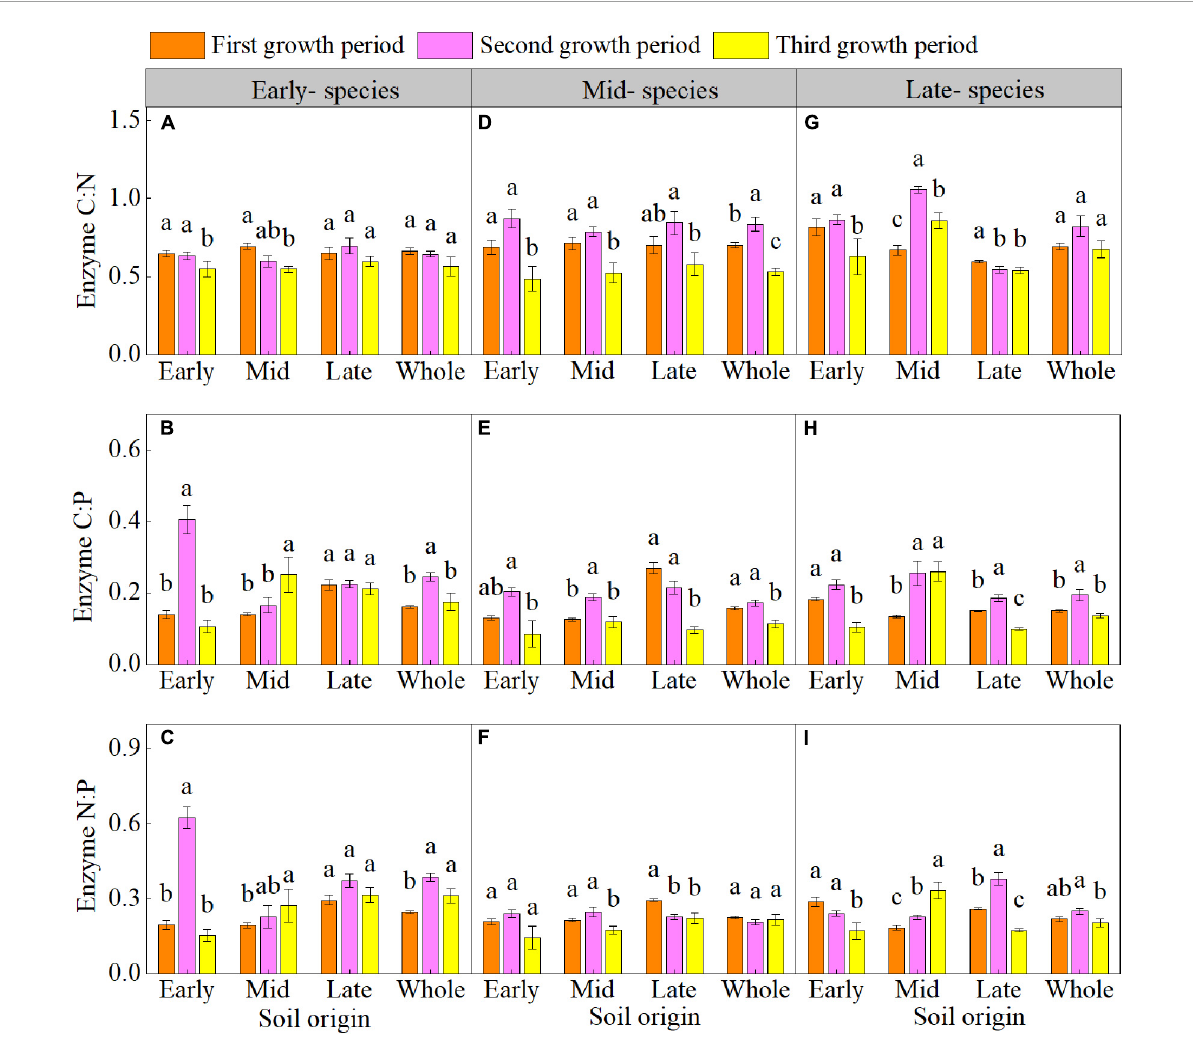
FIGURE3 Mean ( ± SE) ( n = 5) enzyme carbon-nitrogen-phosphorus stoichiometry (enzyme C:N, enzyme C:P, and enzyme N:P) of early- (A–C) , mid- (D–F) , and late- species (G–I) over the three growth periods. “Whole” is the average enzyme C:N, enzyme C:P, and enzyme N:P of the same species in the three soils. Different lower letters indicate significant differences in mean enzyme C:N, enzyme C:P, and enzyme N:P among the three growth periods based on Duncan’s post-hoc test ( p <